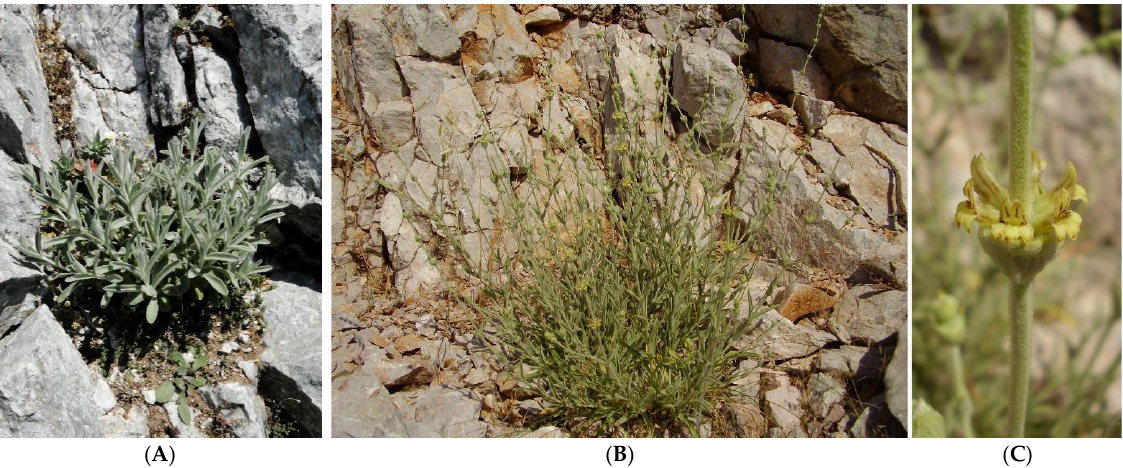
Figure 3. Young spring shoots ( A ) and wild-growing individual of Sideritis sipylea in summer bloom ( B ) showing typical yellow brown-striped bilabiate flowers arranged in remote clusters ( C ). Photographs B and C: Anastasia Stefanaki (reproduced with permission).